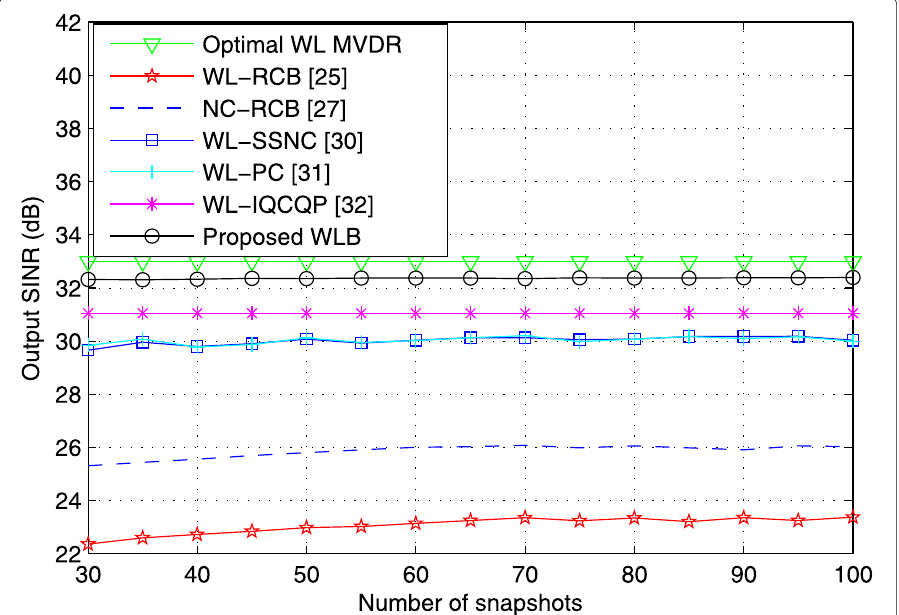
Fig. 9 Example 4. Output SINR of all WLBs versus the number of snapshots